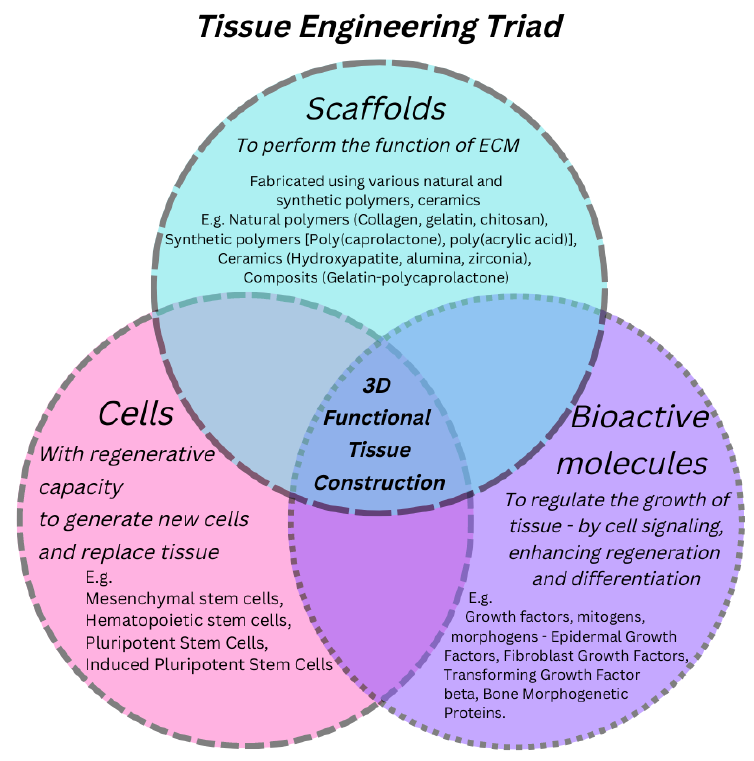
Figure 1. Tissue Engineering